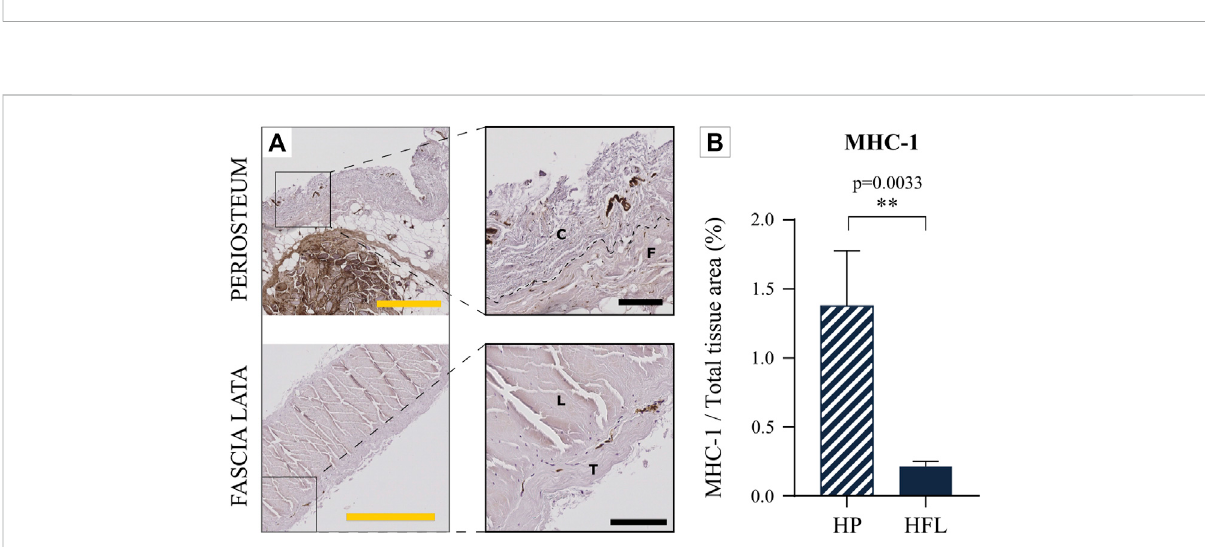
FIGURE 8 Comparison of the HP (top) and HFL (bottom) by immunohistochemistry for MHC-1 (A) (including zoom in) and MHC-1 quanti fi cation ( N = 4 donors x three samples from each donor leading to n = 12 specimens analyzed for each tissue) (B) . C: cambial layer, F: fi brous layer, L: longitudinal layer, T: transverse layer, HP: human periosteum, HFL: human fascia lata. Black scale bars: 100 µm. Yellow scale bars: 500